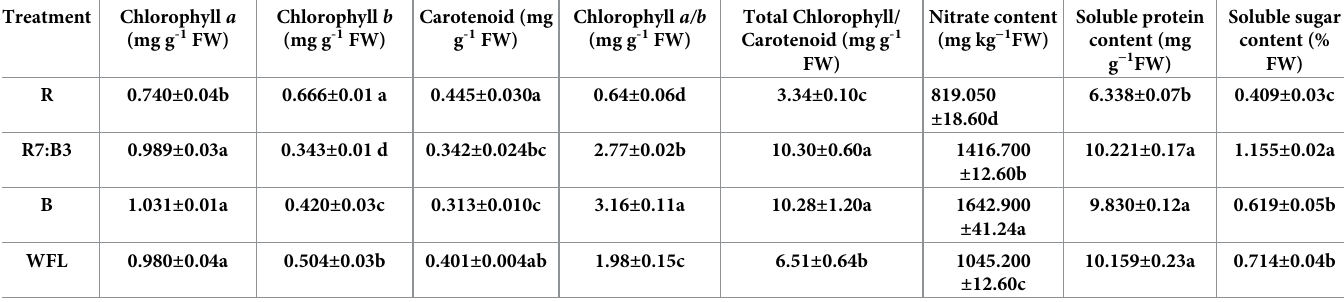
Table 4. Effect of LED light ratios on chlorophyll and carotenoid contents, and biochemical contents in grafted seedlings. Treatment Chlorophyll a (mg g -1